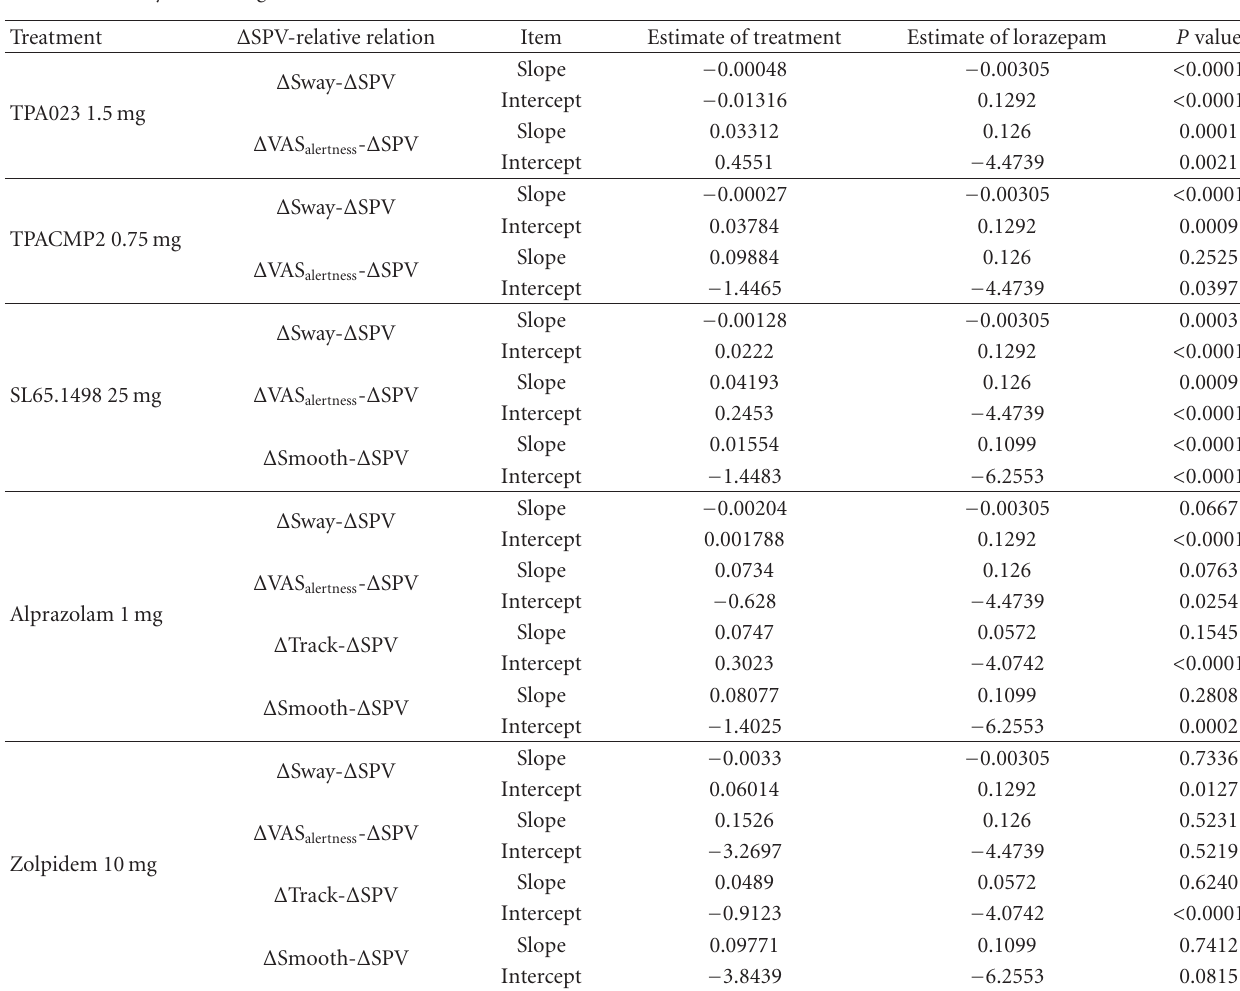
Table 4: Results of the linear model for saccadic peak velocity change from baseline and log body sway change from baseline by treatment with treatment by SPV change from baseline as